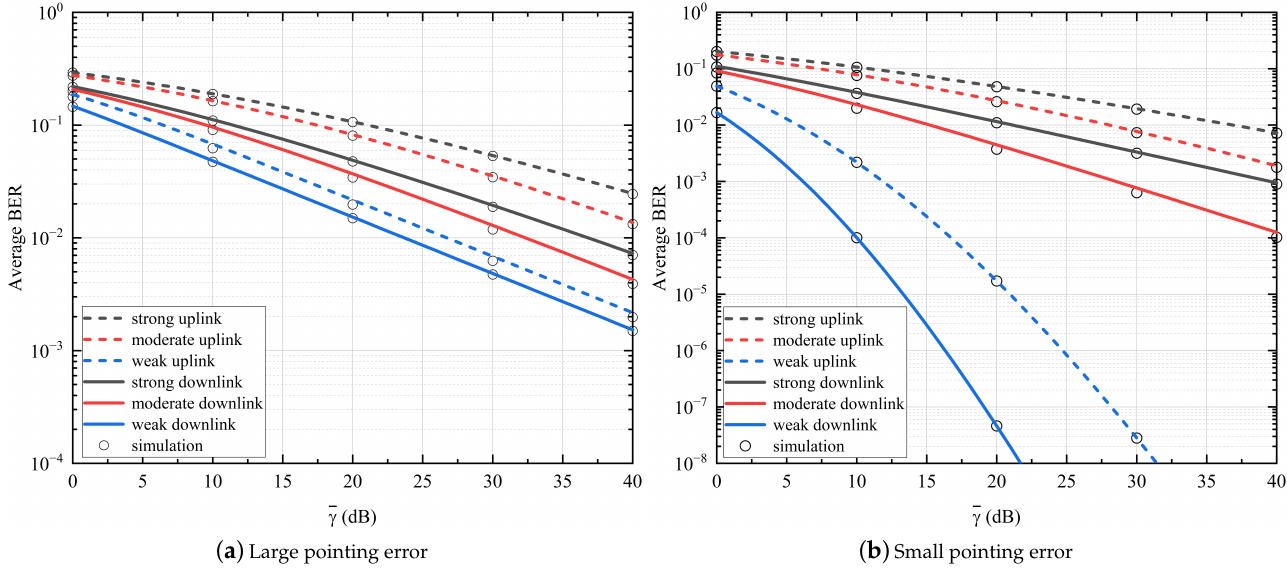
Figure 8. Average BER under different pointing error and atmospheric turbulence when d = 5.0 km, L = 32, N =